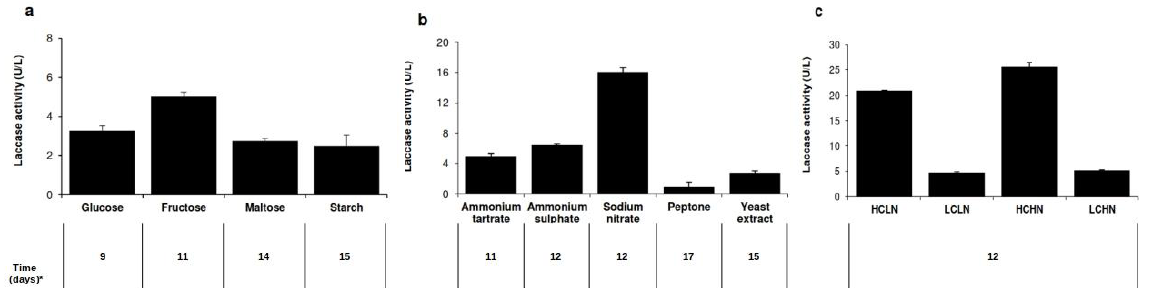
Figure 2. Effect of different carbon and nitrogen sources on the laccase production by T. terrestris Co3Bag1, ( a ), carbon sources (10 g/L); ( b ), nitrogen sources (2 g/L); ( c ), HCLN (high carbon, 20 g/L, and low nitrogen, 2 g/L); LCLN, (low carbon, 5 g/L, and low nitrogen, 2.0 g/L); HCHN, (high carbon, 20 g/L, and high nitrogen, 5 g/L); and LCHN (low carbon, 5g/L, and high nitrogen, 5g/L). * Time (days) corresponding to the day of maximal laccase activity